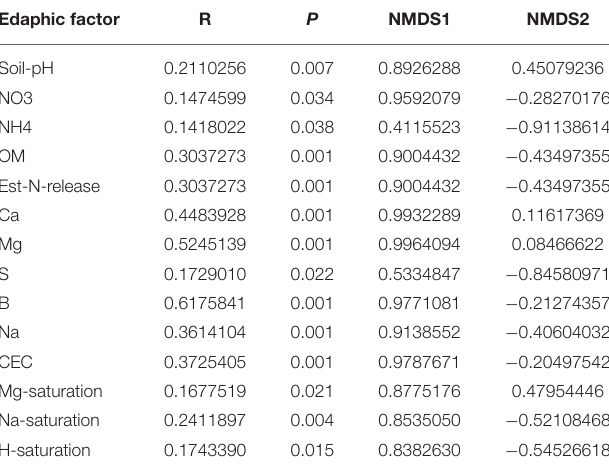
TABLE 5 | Influence of edaphic factors on non-metric multidimensional scaling (NMDS) ordination constructed using the 16S rRNA-based nitrifier Bray-Curtis dissimilarity